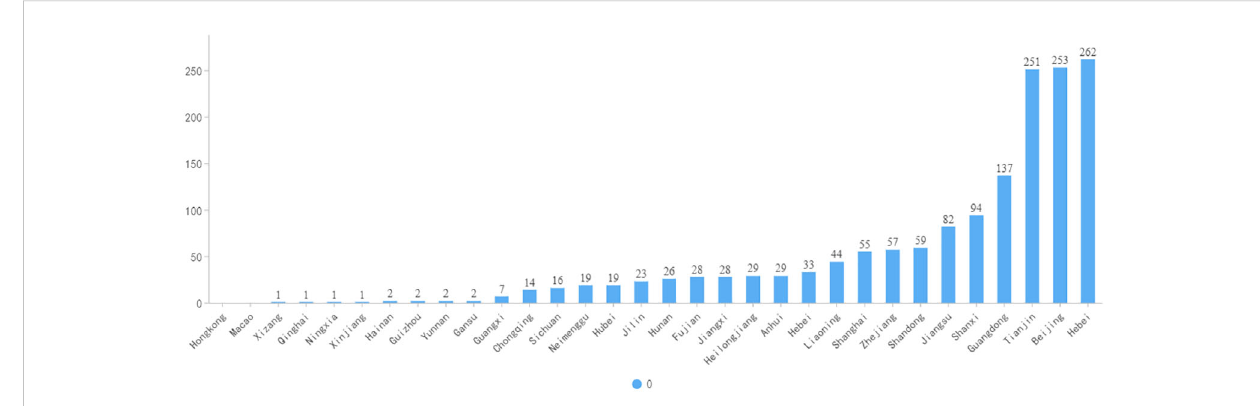
FIGURE 3 Participants ’ provinces of